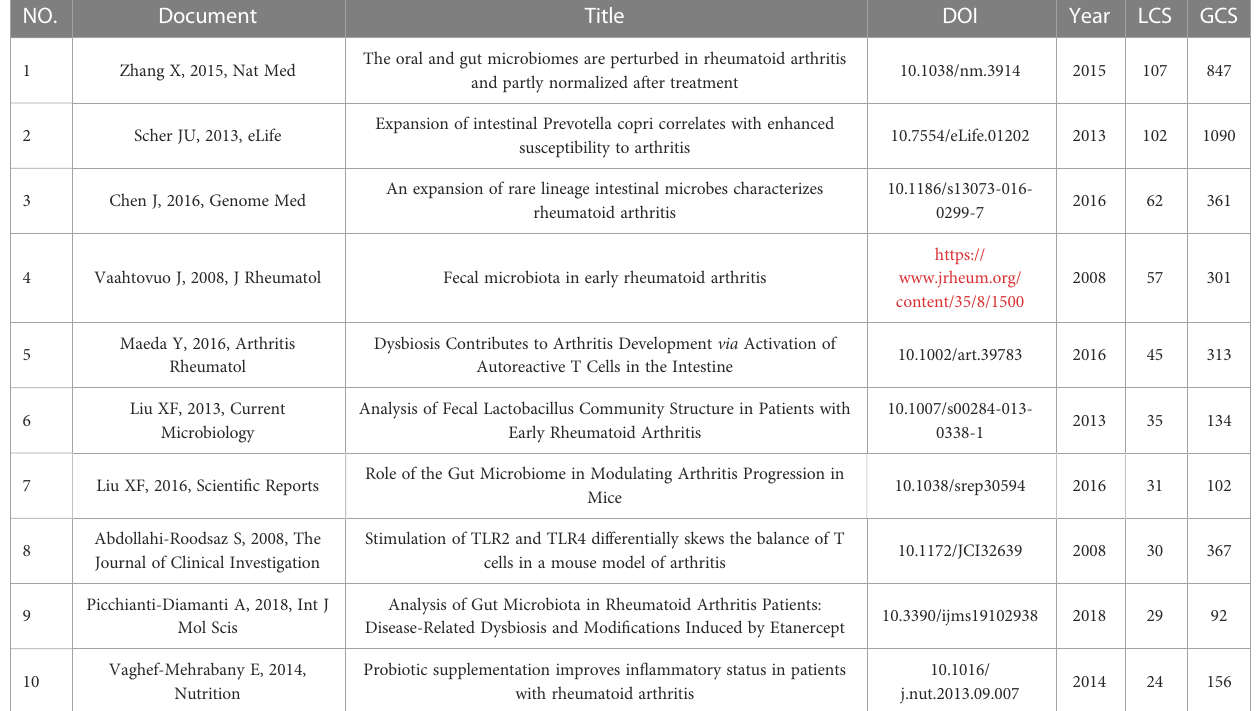
TABLE 5 The top 10 highly local cited research articles.